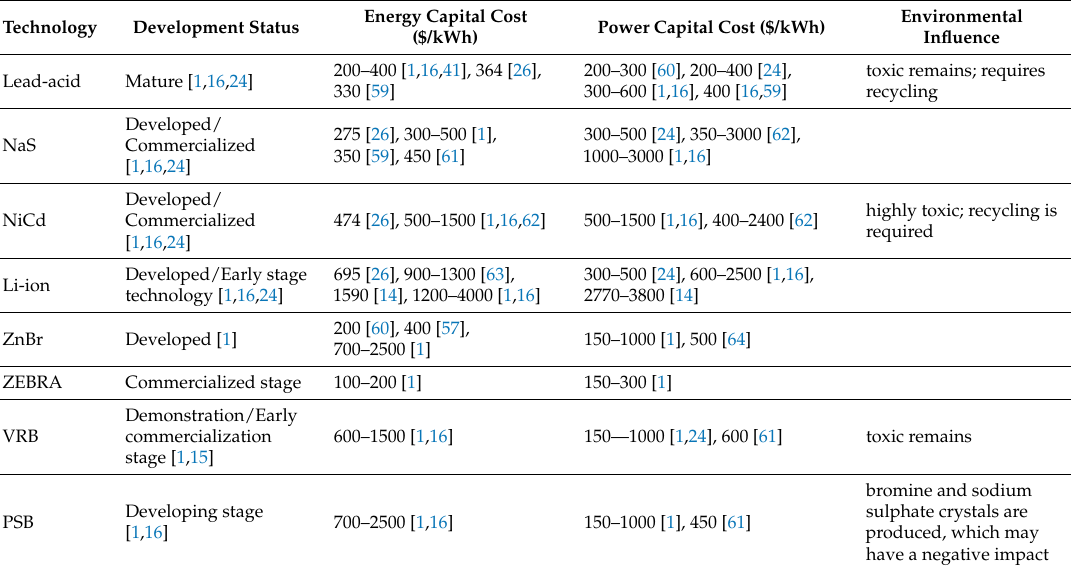
Table 2. Cost and development status comparison of the battery technologies.